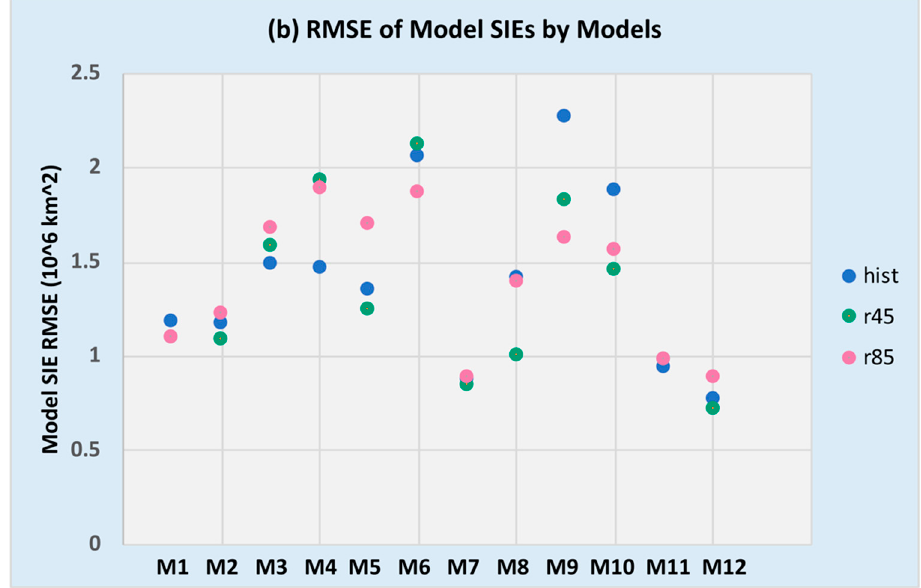
Figure 7. The same as Figure 6 except for the root mean square errors (RMSE) of model SIEs from observed.